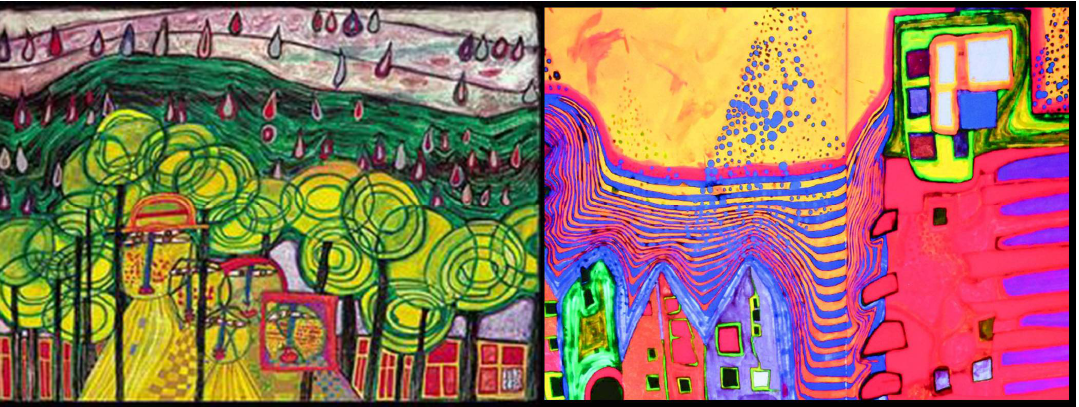
Figure 4. Hundertwasser’s images with the